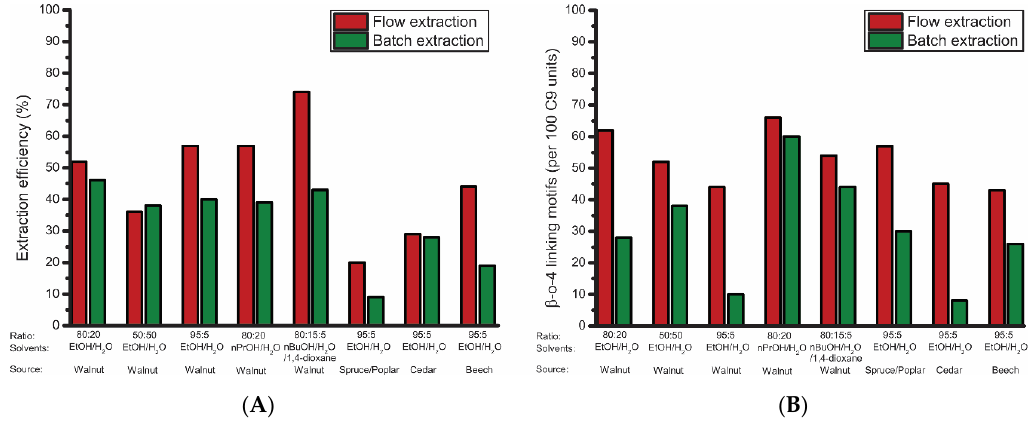
Figure 9. Comparison of flow-through and batch extractions, showing the influence of the reactor setup on ( A ) extraction efficiency (corrected for alcohol incorporation) and ( B ) total β-O-4 content as determined by 2D HSQC.